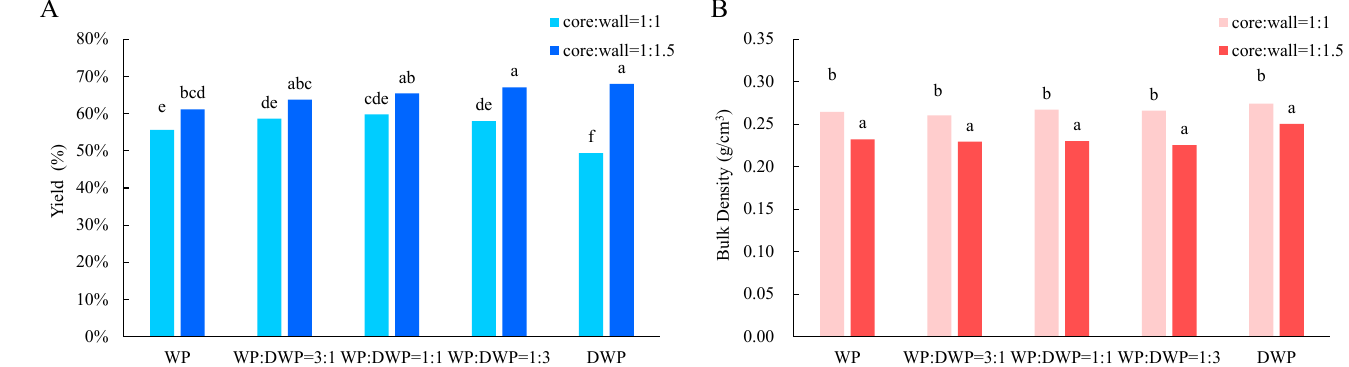
Figure 3. Yield ( A ) and bulk density ( B ) of microencapsulated L. plantarum 299v strain with different core-to-wall ratios and wall material ratios. WP: whey protein, DWP: denatured whey protein. Results are shown as the means and standard deviations. Significant differences ( p < 0.05) were indicated by superscript